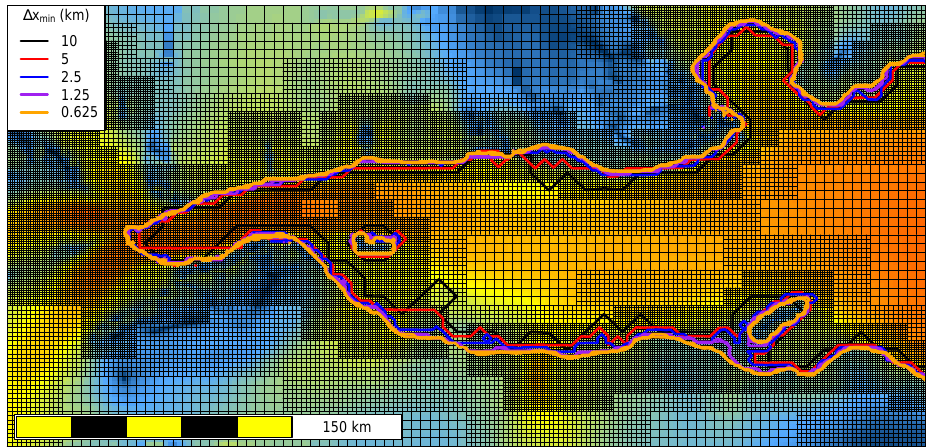
Figure 4. Mesh resolution and grounding line migration. Grounding lines in the year 2200 are plotted for HadCM3/A1B/None/FESOM+ simulations carried out on AMR meshes with the finest resolution 1x min ranging from 10km to 625m. The grounding lines are conver- gent with resolution: there is very little difference between the higher resolution results, and somewhat more between the lower resolution calculations. The mesh shown is from a 1x min = 1 . 25km calculation (finer meshes are too dense to